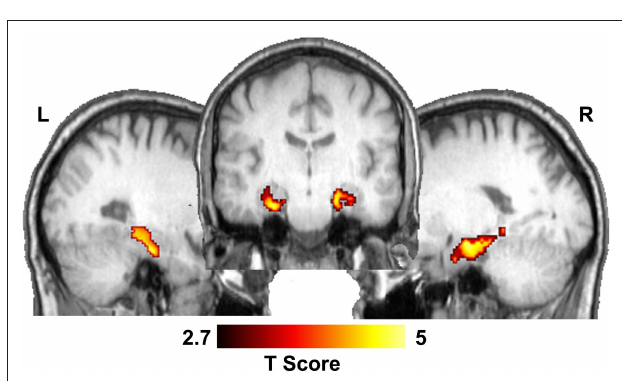
FIguRe 1 | Hippocampal perfusion (CBF) in each subject. The hatched bars are the individuals in each group, and the mean and SD for each group are the solid bars. The individuals in the ET group consistently showed elevated hippocampal perfusion compared with the HAC group. Note that subjects 2, 5, and 6 are the male participants in the ET group.